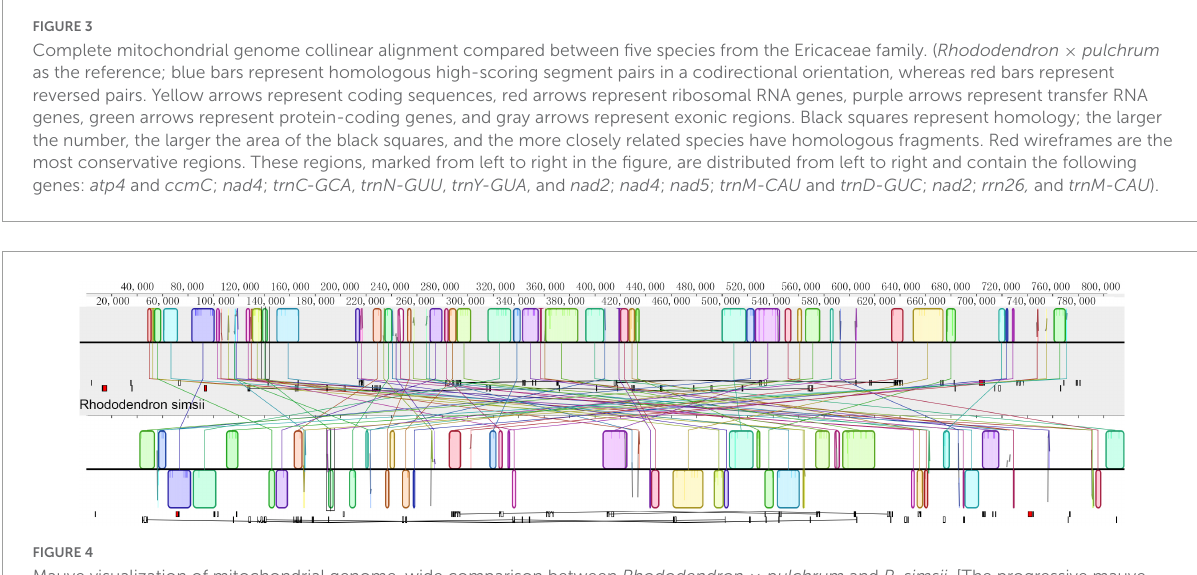
only polyadenine (poly A) or polythymine (poly T), without guanine (G) or cytosine